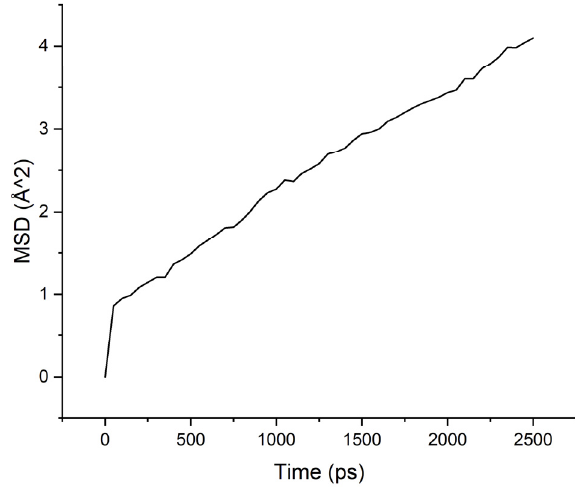
Figure 5. MSD for PAA-isopropanol system.